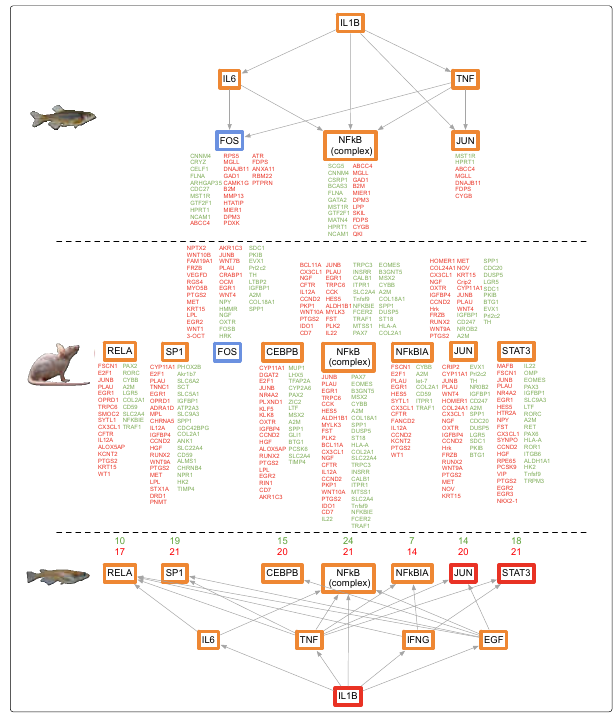
Figure 5. IL1B controls expression of many shared mid-level regulators in the zebrafish (top), medaka (bottom), and mouse (middle) brain datasets, including the key immune and inflammation APR regulator TNF. Genes in red and green are modulated DEGs, and genes in orange and blue are predicted by IPA to be up and down, respectively. Due to the robust dataset in medaka, the number of genes up- and down-modulated are listed in red and green, respectively.